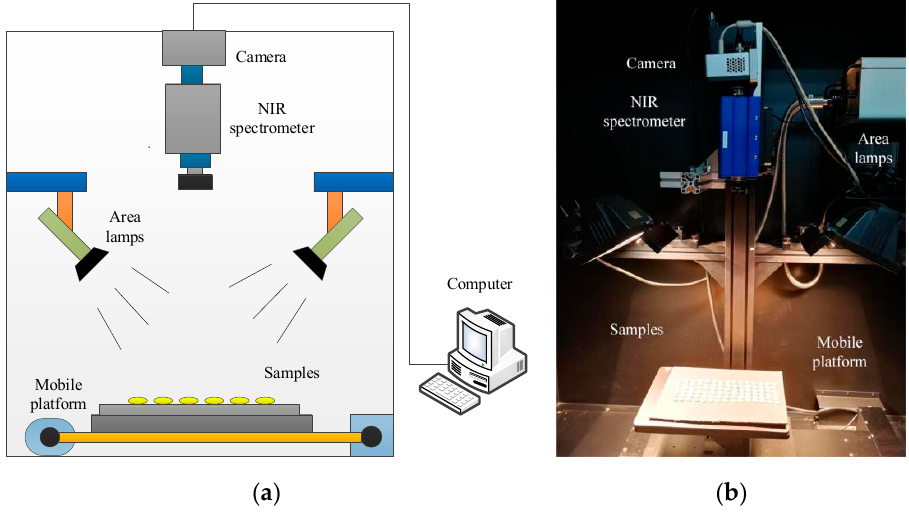
Figure 1. Hyperspectral imaging system. ( a ) Block diagram for HIS; ( b ) Real laboratory